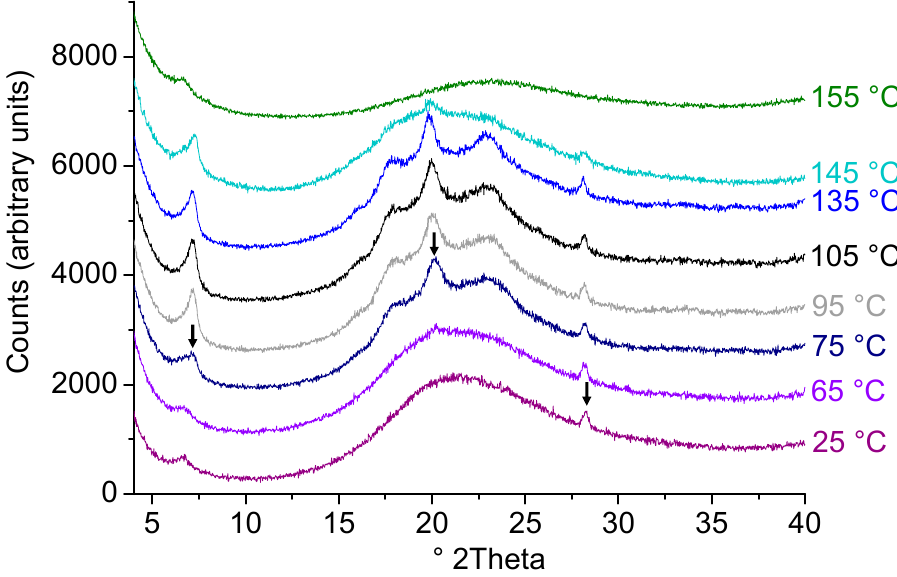
Figure 5. X-ray powder diffraction (XRPD) diffractograms of spray dried PPrOx, recorded during the temperature resolved experiment. Bragg peaks that were initially present or appeared upon heating are indicated with arrows. Created with Origin 8.5 from OriginLab (Northampton, Massachusetts, USA).